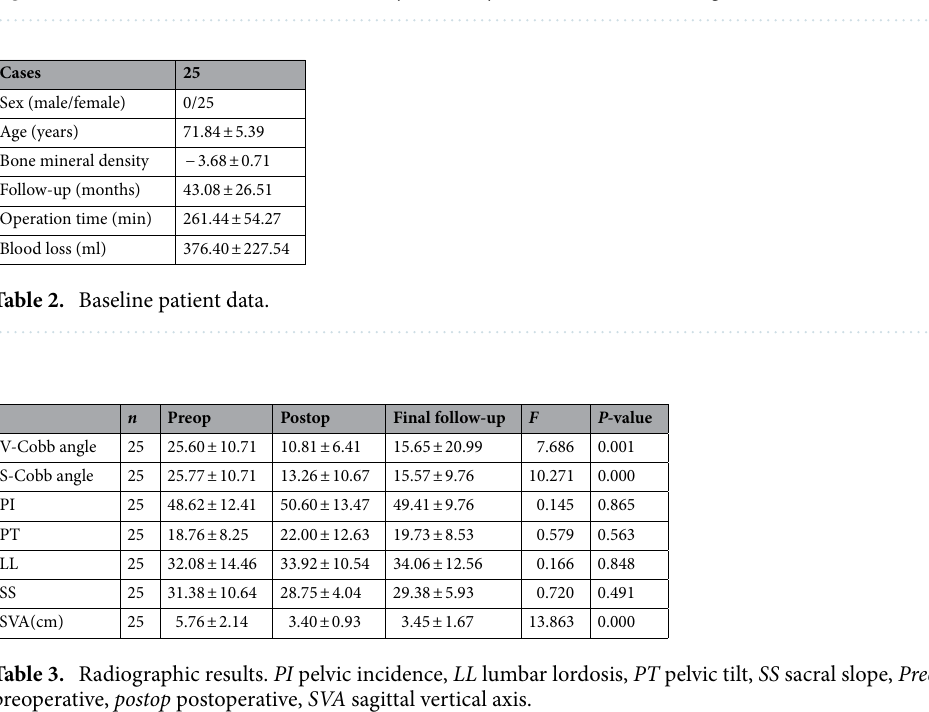
Figure 5. ODI and VAS scores. ODI Oswestry Disability Index, VAS visual analogue scale.